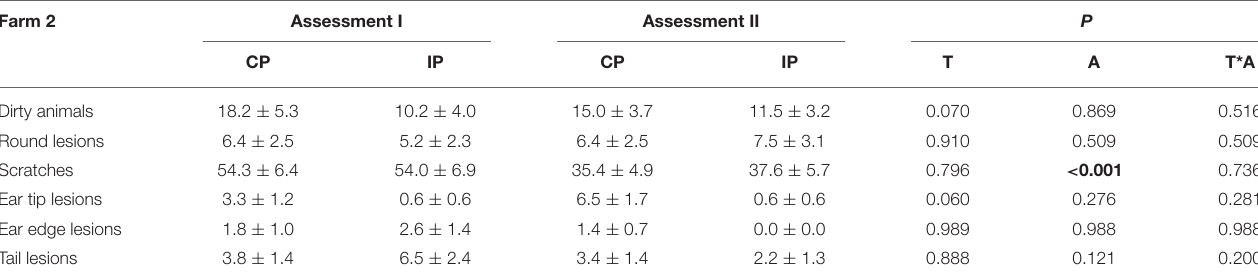
TABLE 8 | Prevalence of lesions and soiled pigs (mean percentage of animals per pen; LS-means LSM and standard error of means SEM) for pigs in IP (improved pens) and CP (control pens) during assessments I (baseline) and II (middle of the fattening period) on Farm 2. Farm 2